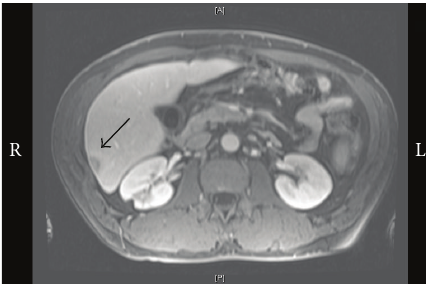
Figure 2: Magnetic resonance of abdomen showing two lesions within the right lobe of the liver along the peripheral surface (black